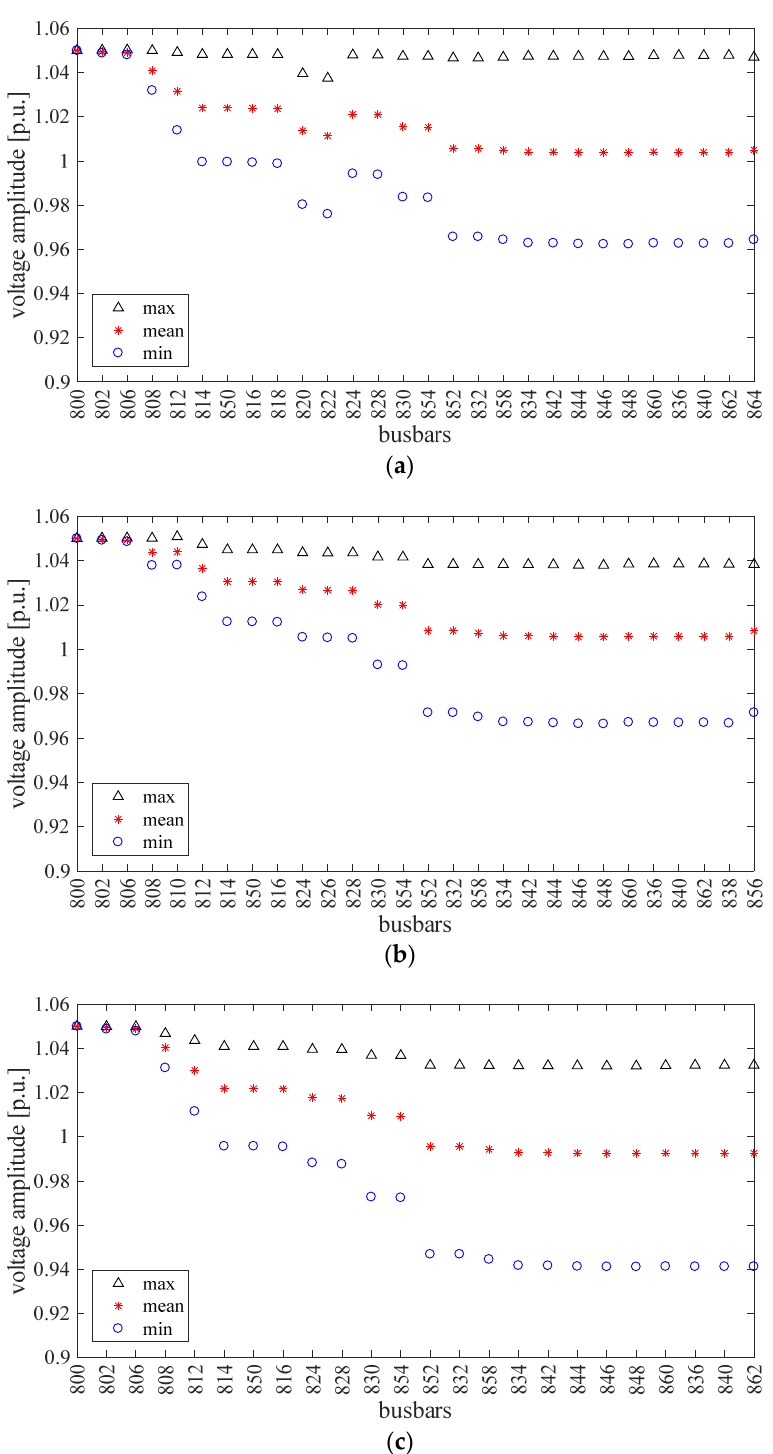
Figure 6. Minimum, mean, and maximum values of phase voltage amplitude ( a ): phase a; ( b ): phase b; ( c ): phase c, at all buses (in one year).